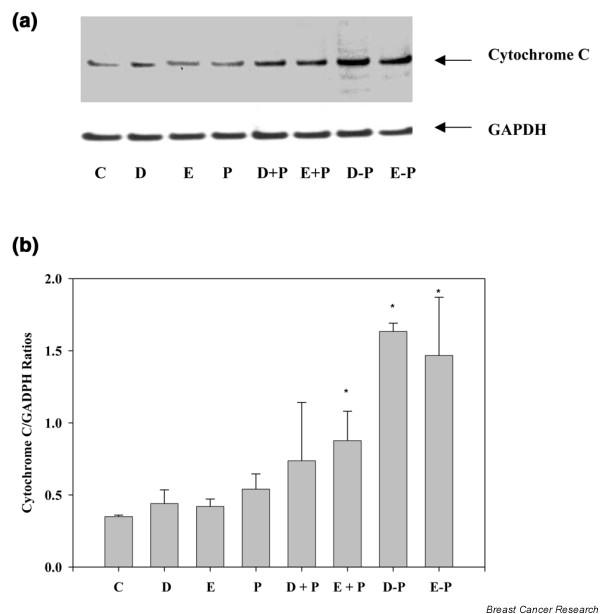
Effect of propofol-docosahexaenoic acid (propofol-DHA) and propofol-eicosapentaenoic (propofol-EPA) conjugates on cytochrome c release. MDA-MB-231 cells (0.5 × 106/well) were grown in 96-well plates for 24 hours at 37°C in a humidified CO2 incubator with control or test compounds. (a) Postnuclear supernatant was used for the determination of cytochrome c release using immunobloting as described in the Materials and Methods section. The relative distributions of cytochrome c and glyceraldehyde-3-phosphate dehydrogenase (loading control) were determined. (b) Quantification was by densitometry analysis with the Kodak imaging system. Results are means ± SEM for three experiments. The results were analyzed by analysis of variance and Dunnett's multiple comparison test to control the Type I experimental wise error. Significant differences from the control (P < 0.05) are indicated with an asterisk. D, 25 μM DHA; E, 25 μM EPA; P, 25 μM propofol; D+P, 25 μM DHA plus 25 μM propofol; E+P, 25 μM EPA plus 25 μM propofol; D-P, 25 μM propofol-DHA; E-P, 25 μM propofol-EPA.